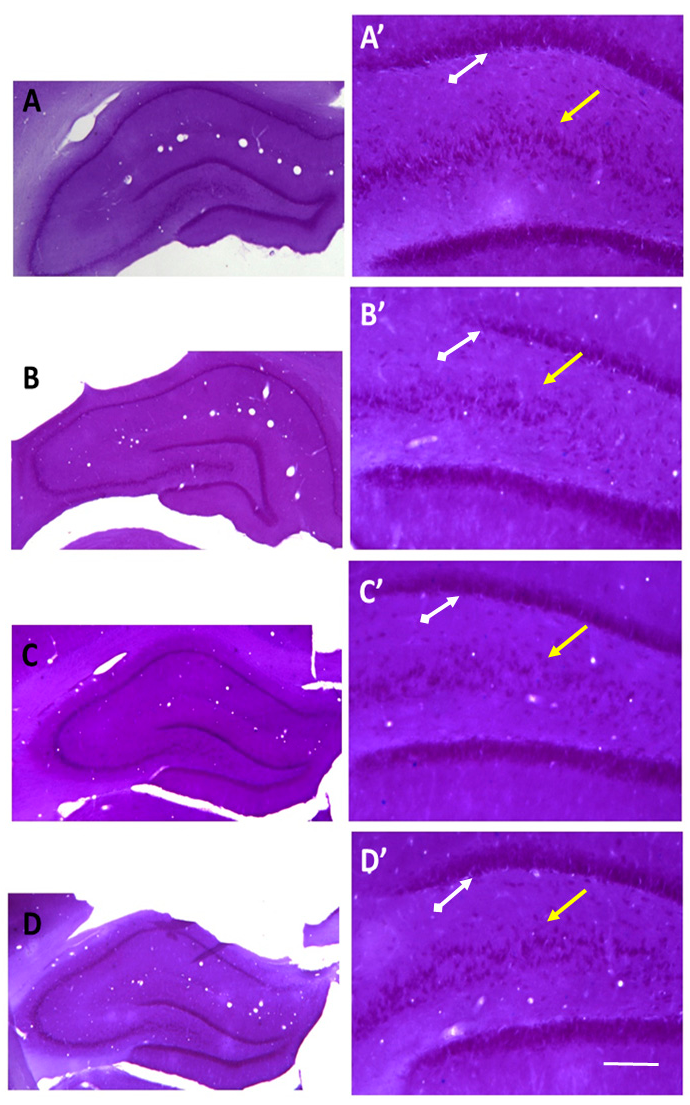
Figure 7. Photomicroscopic view of the hippocampus in the normoglycemic rats administered saline solution ( A ) and diabetic rats administered saline ( B ), 40 mg/kg agomelatine ( C ) or 80 mg/kg agomelatine ( D ). Scale bar = 80 microns in ( A – D ) and 20 microns in A’ – D’ . White arrows display the CA1–3 subregions of the hippocampus while yellow arrows indicate the dentate gyrus. In comparison to diabetic rats, in control and agomelatine-treated groups pyramidal cells and granule cells were more densely packed in CA1–3 and dentate gyrus, respectively.